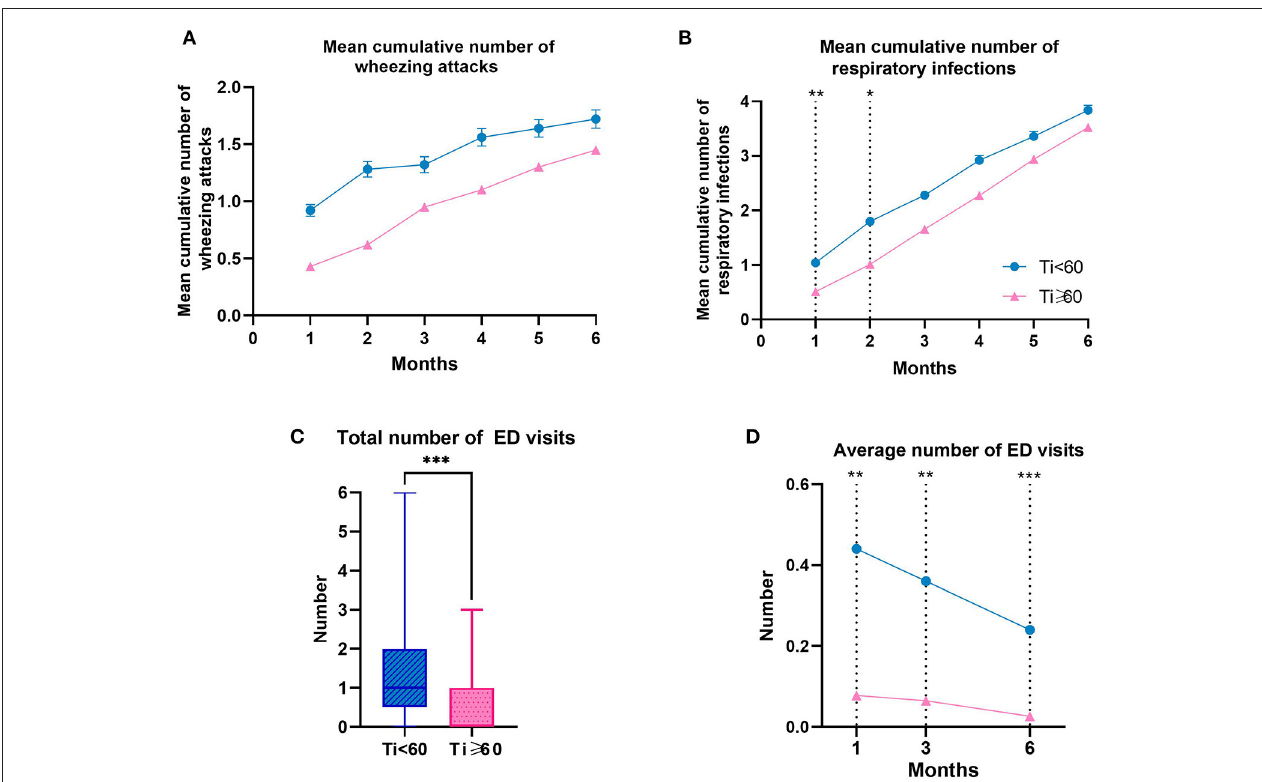
FIGURE 5 | Clinical Manifestation Related Characteristics and the Number of ED Visits of Pre-schoolers with Asthma by Groups. (A, B) Data were calculated using a generalized estimating equation model adjusted for month. The data are presented as mean ± SEM. Ti, TRACK initial score. ED, Emergency Department. *** P < 0.001, ** P < 0.01, * P <